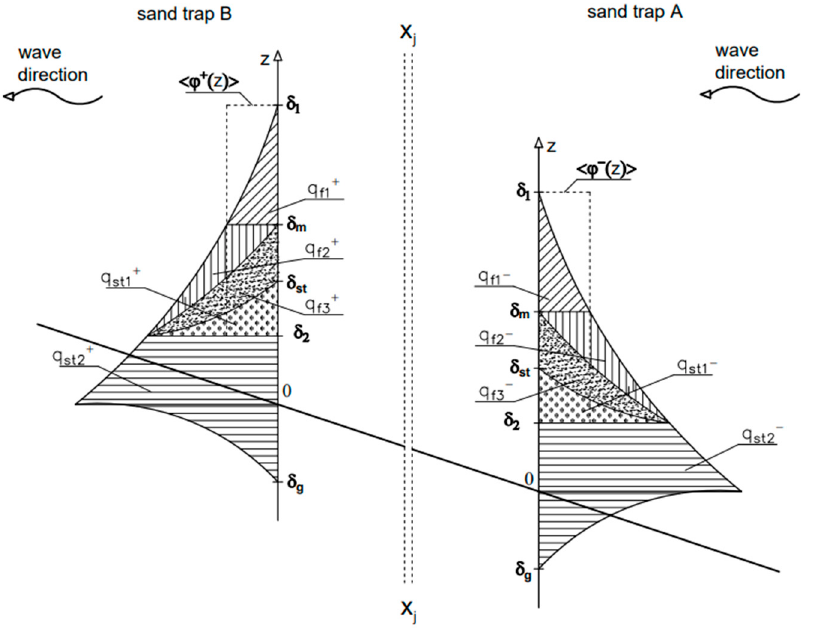
Figure 1. Vertical structure of the wave-induced progressive and reverse sediment fluxes over slopped bed.